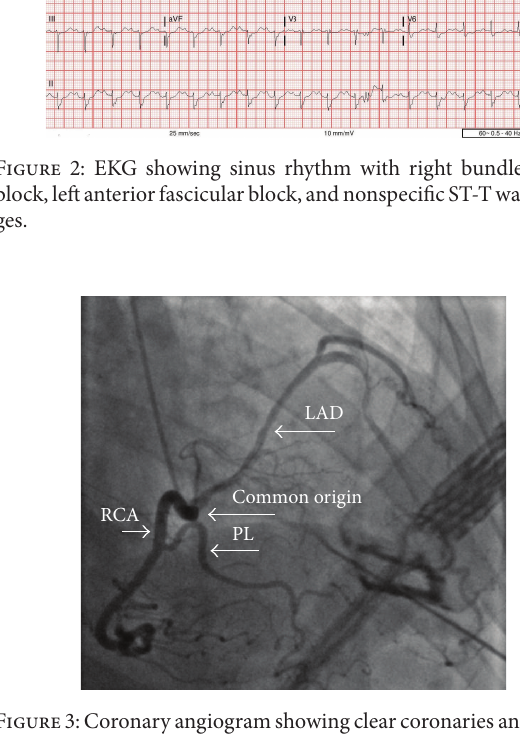
Figure 1: Ventricular fibrillation as the initial rhythm at presenta- tion.